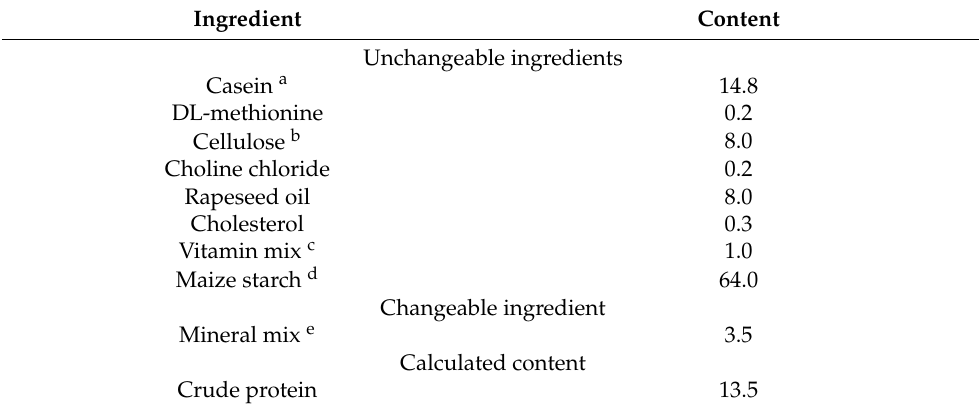
Table 1. Composition of basal diet fed to rats, data presented as percent of content (%).